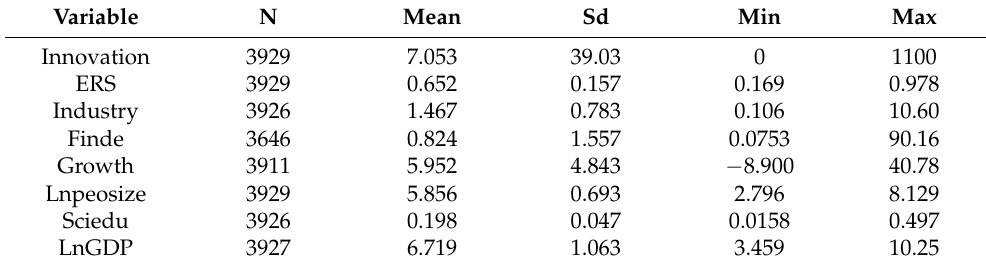
Table 2. Variables